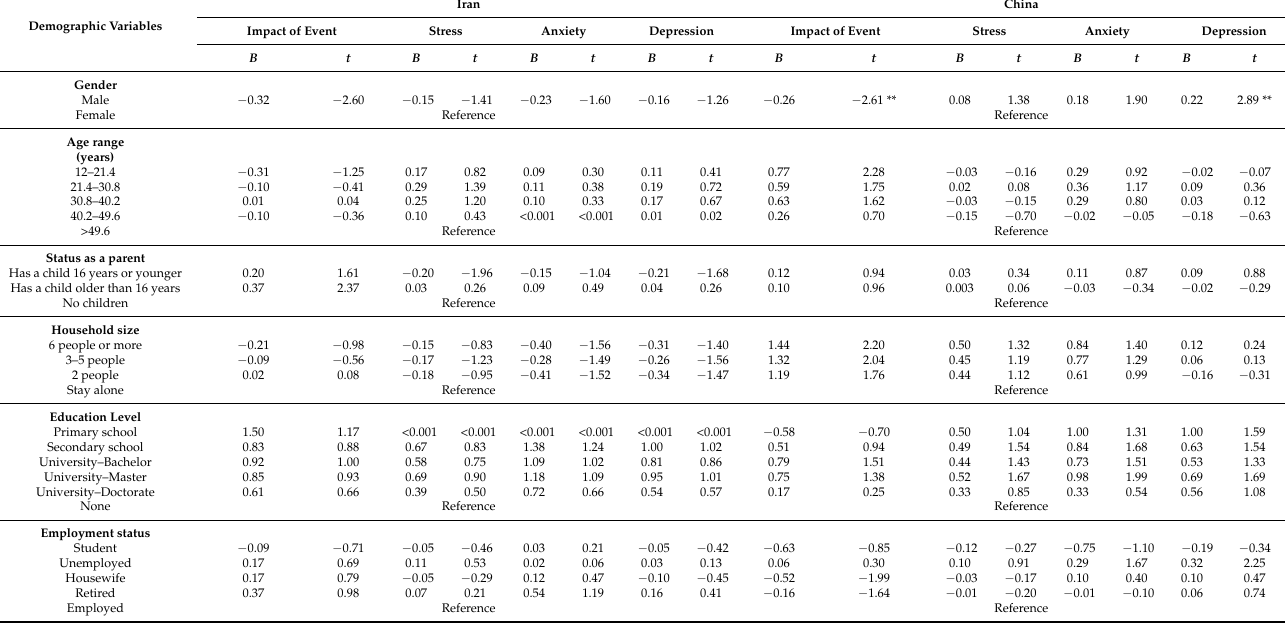
Table 1. The linear regression analysis between demographic variables and mental health parameters in Iranian and Chinese respondents ( n =